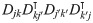
Illustration of the algorithm operating on a case-matrix alone (i.e., D only).In Panel-A we show a large M × N binarized matrix D (black and white pixels correspond to values of ±1, respectively). In the upper left corner of D we’ve inserted a large rank-1 bicluster B (shaded in pink). Our algorithm considers all 2 × 2 submatrices (i.e., ‘loops’) within D. Several such loops are highlighted via the blue rectangles (the corners of each rectangle pick out a 2 × 2 submatrix). Generally speaking, loops are equally likely to be rank-1 or rank-2. Some loops, such as the loop shown in red, are entirely contained within B. These loops are more likely to be rank-1 than rank-2. In Panel-B we show some examples of rank-2 and rank-1 loops. Given a loop with row-indices j, j′ and column-indices k, k′, the rank of the loop is determined by the sign of DjkDkj′⊺Dj′k′Dk′j⊺. Our algorithm accumulates a ‘loop-score’ for each row j and each column k. In its simplest form, the loop-score for a particular row j is given by Σj′,k,k′DjkDkj′⊺Dj′k′Dk′j⊺=[DD⊺DD⊺]jj. Analogously, the loop-score for a column k is given by [D⊺DD⊺D]kk. In Panel-C we show the distribution of loop-scores we might expect from the rows or columns within D. The blue-curve corresponds to the distribution of scores expected from the rows/cols of D that are not in B, whereas the red-curve corresponds to the distribution of scores expected from the rows/cols of B. In Panel-D we show the distribution of loop-scores we might expect by pooling all rows or columns of D. The rows or columns that correspond to the lowest scores are not likely to be part of B.